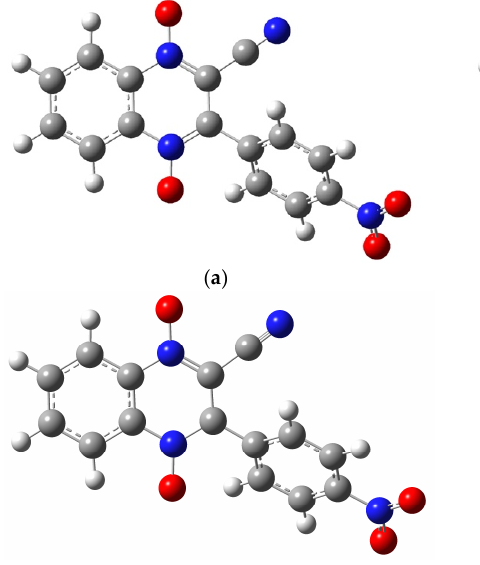
Figure A2. The individual structures for molecule E1 optimized using the 6-31g basis set: ( a ) the neutral molecule; ( b ) the possible anion product of Wave 1 with the radical on C2; ( c ) the possible anion product of Wave 1 with the radicals on C3; ( d ) the possible dianion product of the Nitro Wave with radicals on C2 and on the nitro group; ( e ) the possible dianion product of the Nitro Wave with radicals on C3 and on the nitro group; and ( f ) the trianion product of Wave 2. Chemical structures created in GaussView 5 [30] and optimized in Gaussian 09 [31]. References 1. Anderson, R.F.; Yadav, P.; Shinde, S.S.; Hong, C.R.; Pullen, S.M.; Reynisson, J.; Wilson, W.R.; Hay, M.P. Radical Chemistry and Cytotoxicity of Bioreductive 3-Substituted Quinoxaline Di-N- Oxides. Chem. Res. Toxicol. 2016 , 29 , 1310–1324. 2.